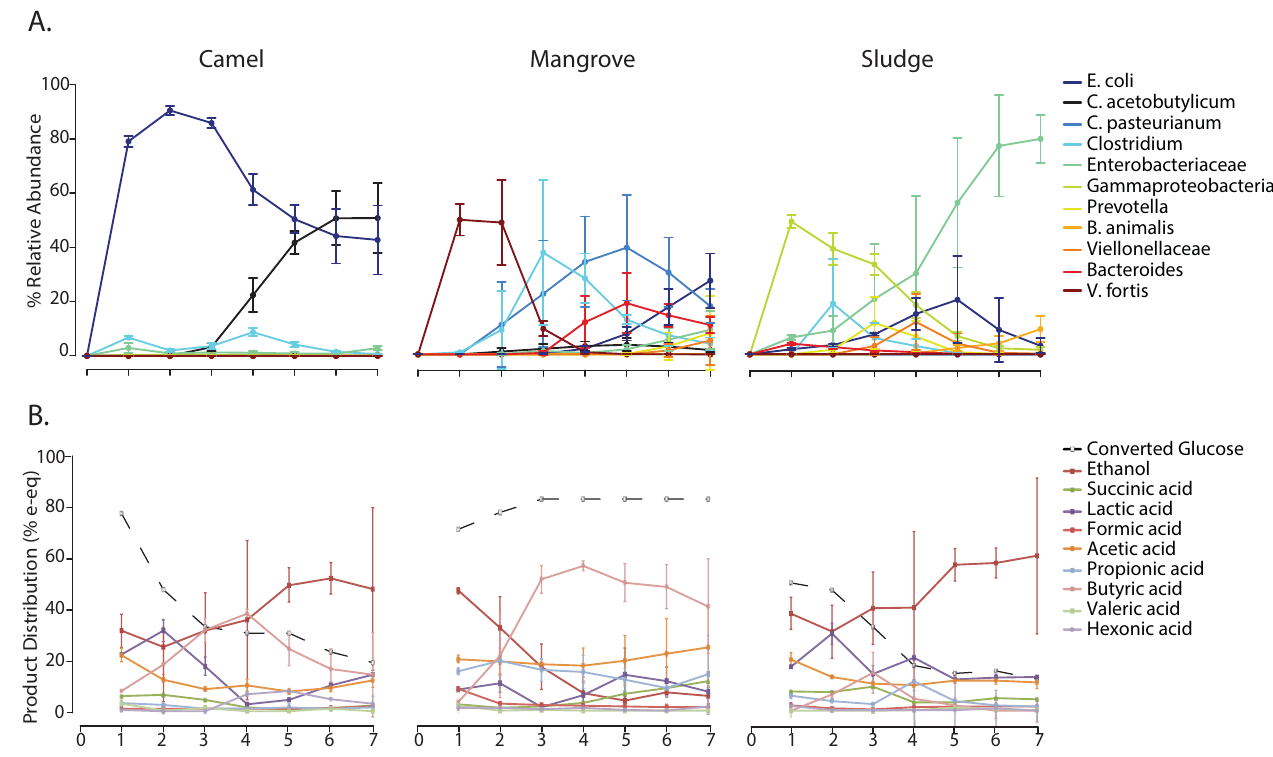
Fig 4. Dynamicsof enriched OTUs and reactor chemical profiles are distinct to initial microbial inoculum. We illustrate changesin averagerelativeabundancesof enrichedOTUs over time (A) and the changesin averageproduct yields in terms of electron equivalents over glucoseconsumedfrom providedfeed (B) for the three inoculasources Camel, Mangrove, and Sludgereactors, respectively.